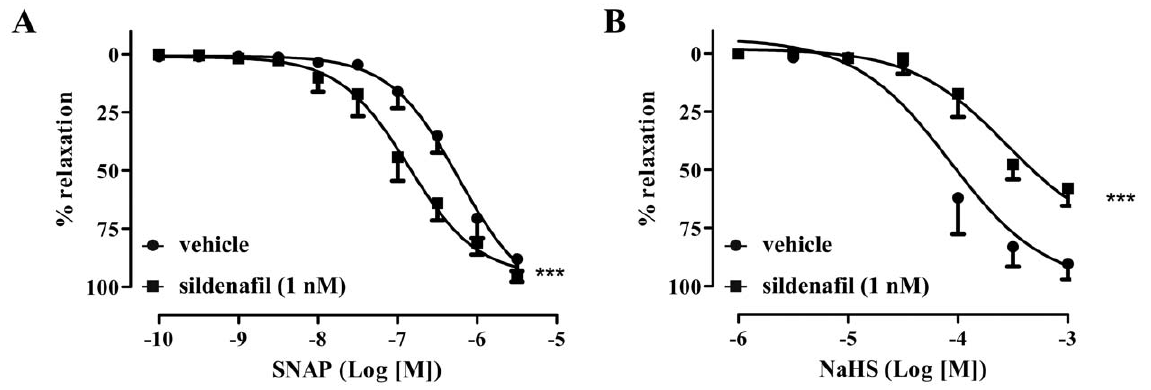
Figure 1. The PDE5 inhibitor sildenafil differentially affects NO and H 2 S-regulated vascular tone. (A) Incubation of isolated aortic rings with sildenafil (1 nM) significantly inhibited NaHS-induced vasodilatation. (B) Incubation of isolated aortic rings with sildenafil (1 nM) significantly enhanced SNAP-induced vasodilatation. *** p , 0.001 vs vehicle (dH 2 O), n=6 for each group.